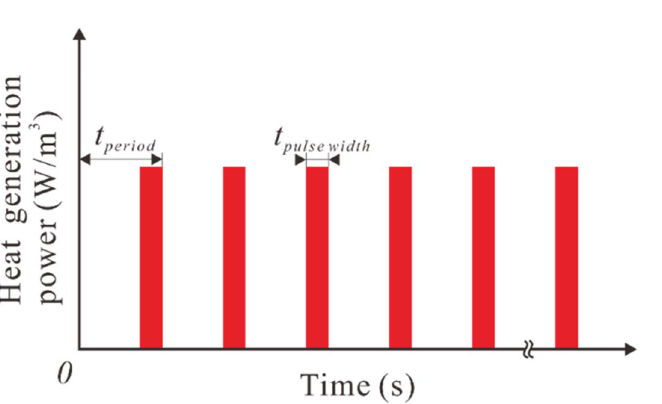
Figure 3. Temporal distribution of the heat source